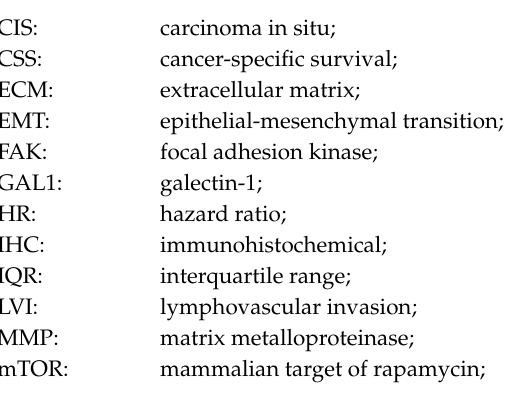
Supplementary File 1: Table S1. All di ff erentially expressed genes (DEGs) between GAL1-vector and GAL1-KD UC